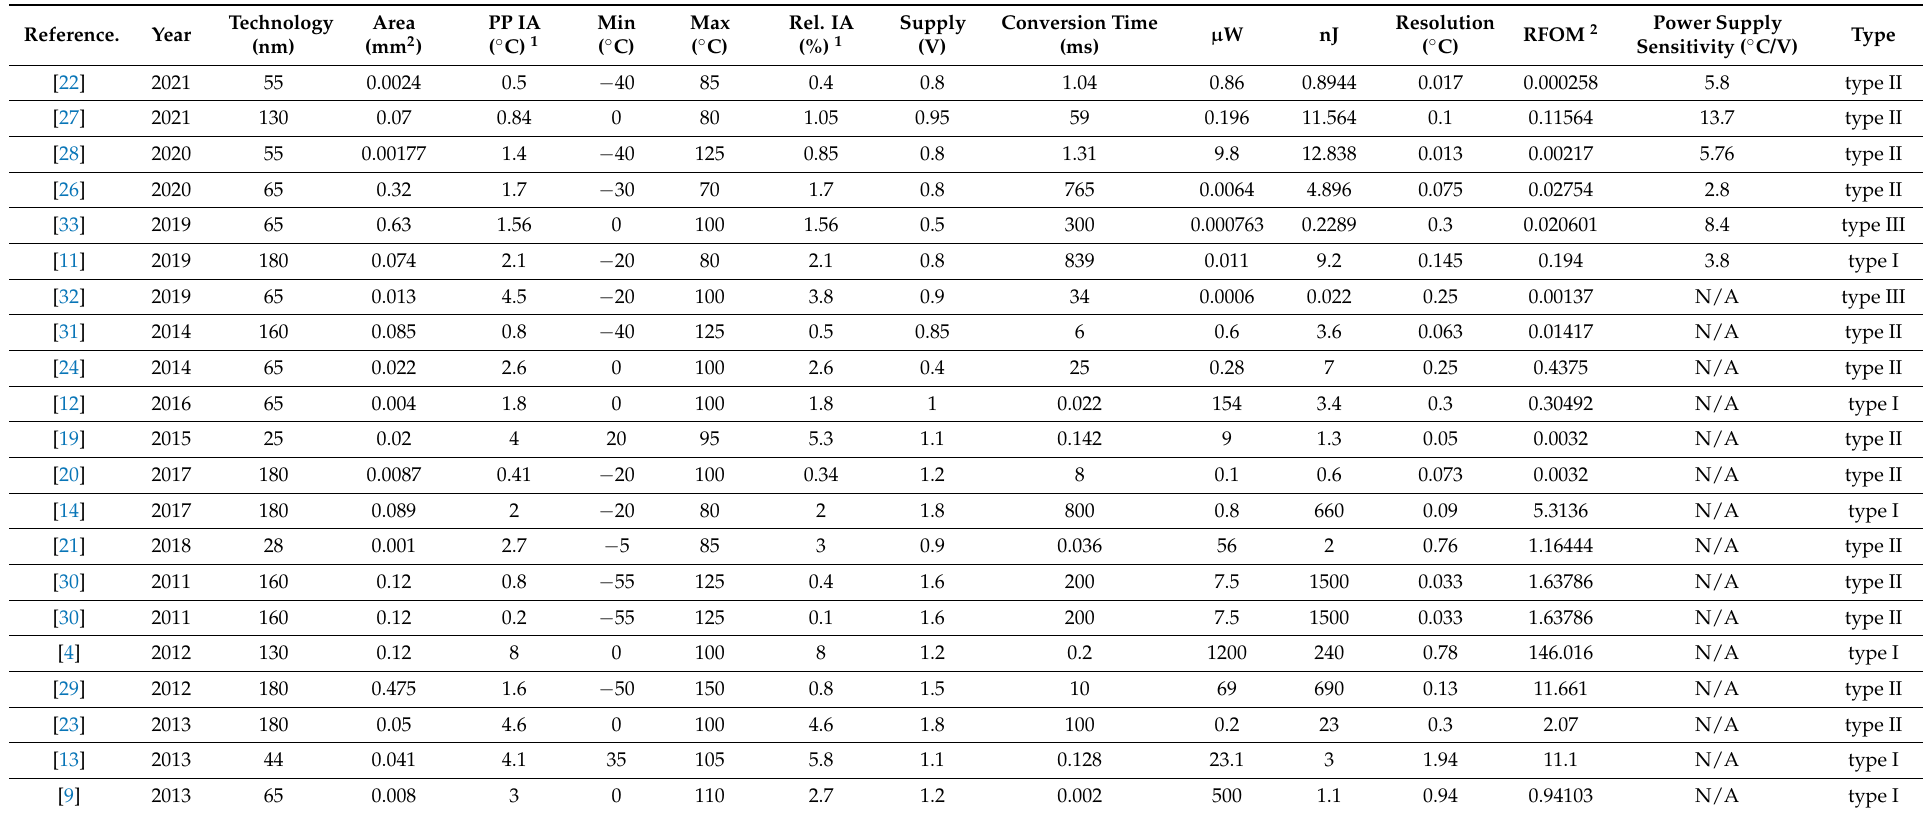
Table 1. The performance summary of the selected MOS-based temperature